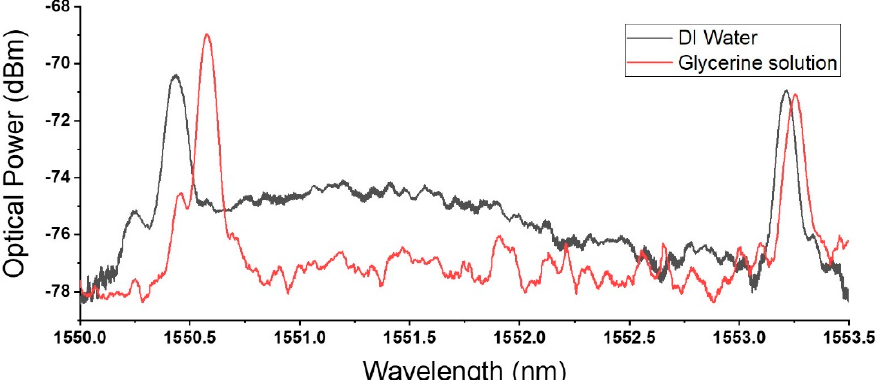
Figure 8. Spectral response in deionized water and a glycerin solution with refractive index of 1.410.